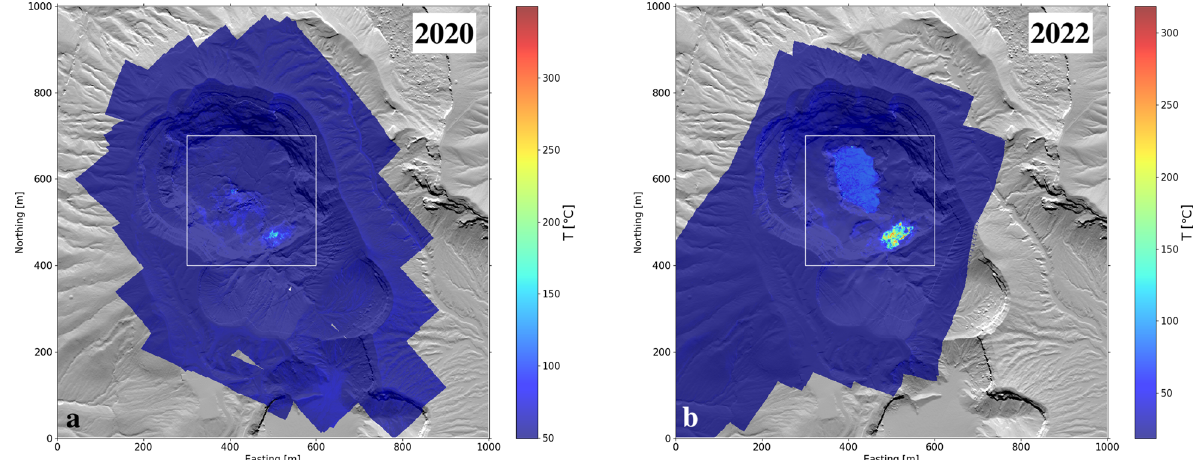
Fig. 5 Orthorectified thermal images of a 2020 and b 2022 surveys. The white rectangles correspond to the area of Fig. 6c and